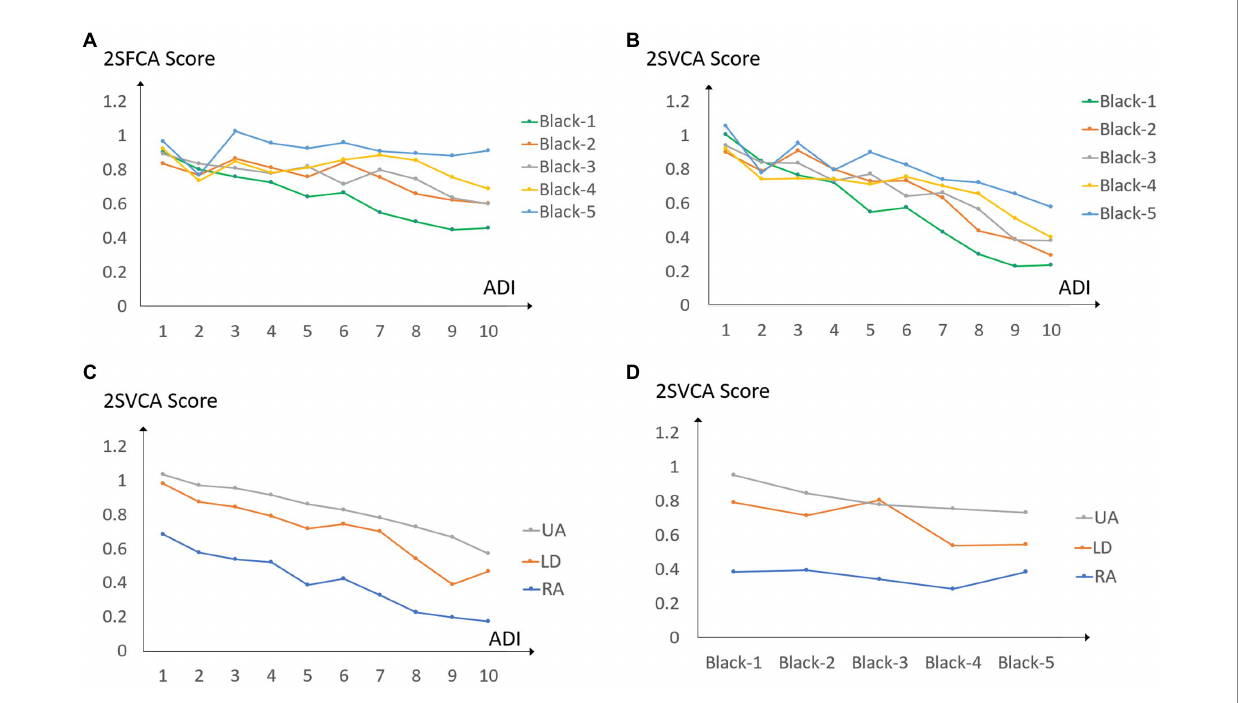
FIGURE 6 (A) 2SFCA scores by ADI and Black population; 2SVCA scores by (B) ADI and Black population, (C) ADI and urbanicity, (D) Black population and